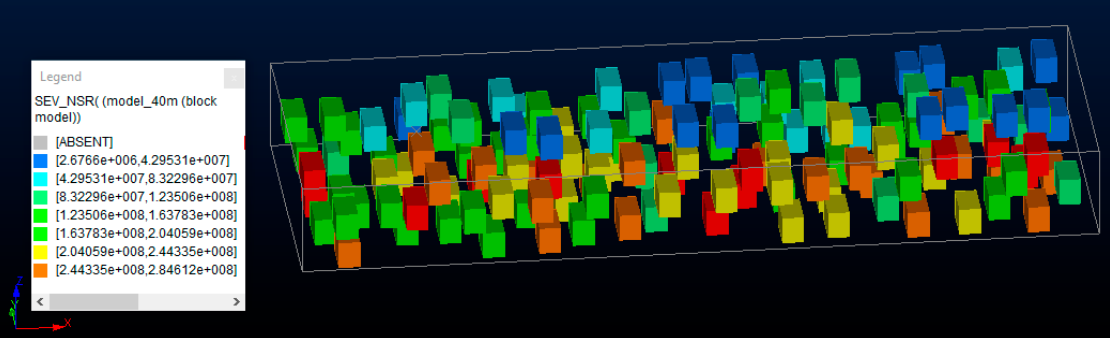
Figure 7. Scenario A: visualisations of the optimum stope layout solution using the DIA with the legend showing SEV in USD. Source: [3].